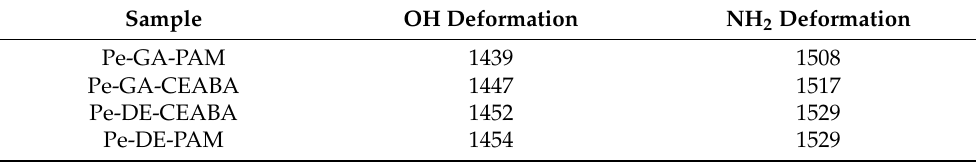
Table 2. Displacement of negative bands in the difference spectra of the treated